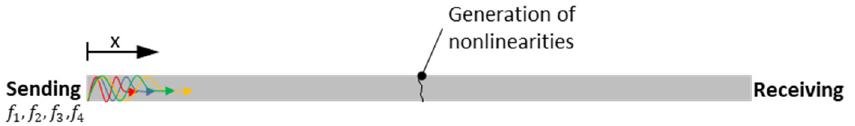
Figure 2. Model—multi-frequency excitation.